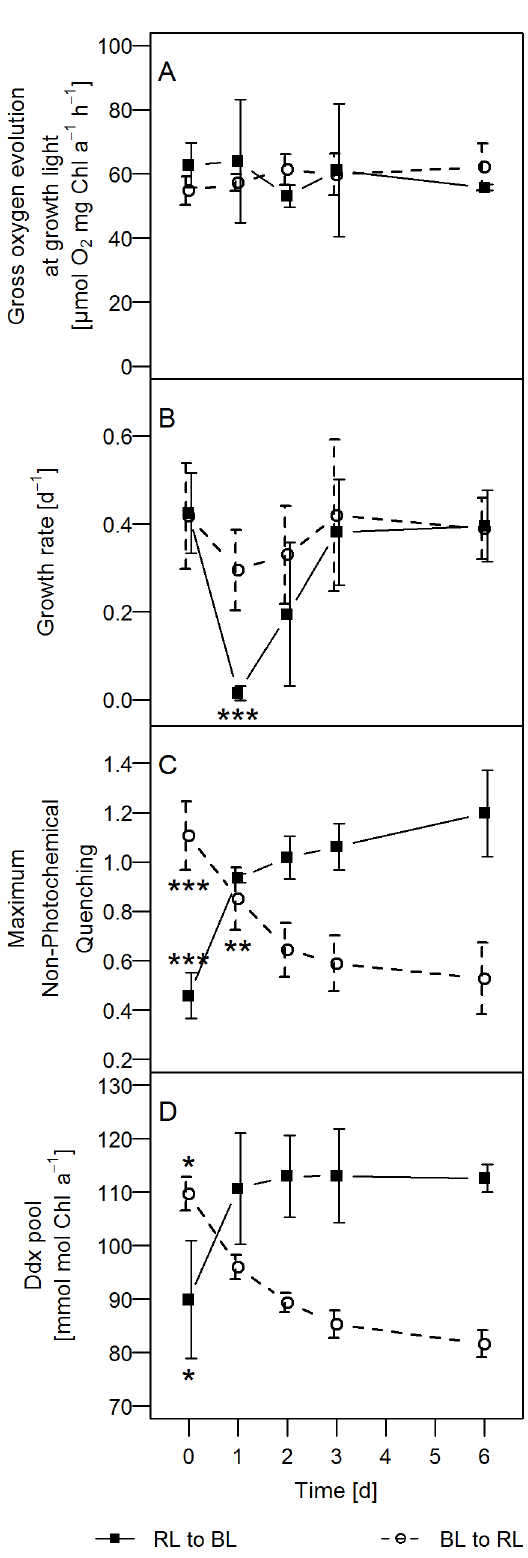
Figure 1. Long-term acclimation to light quality shifts. The acclimation process of P. tricornutum cultures was observed for 6 days after the light quality shift from BL to RL and RL to BL. Shown are (A) estimated gross oxygen evolution rates at growth light conditions, (B) growth rate per day, (C) maximum values of